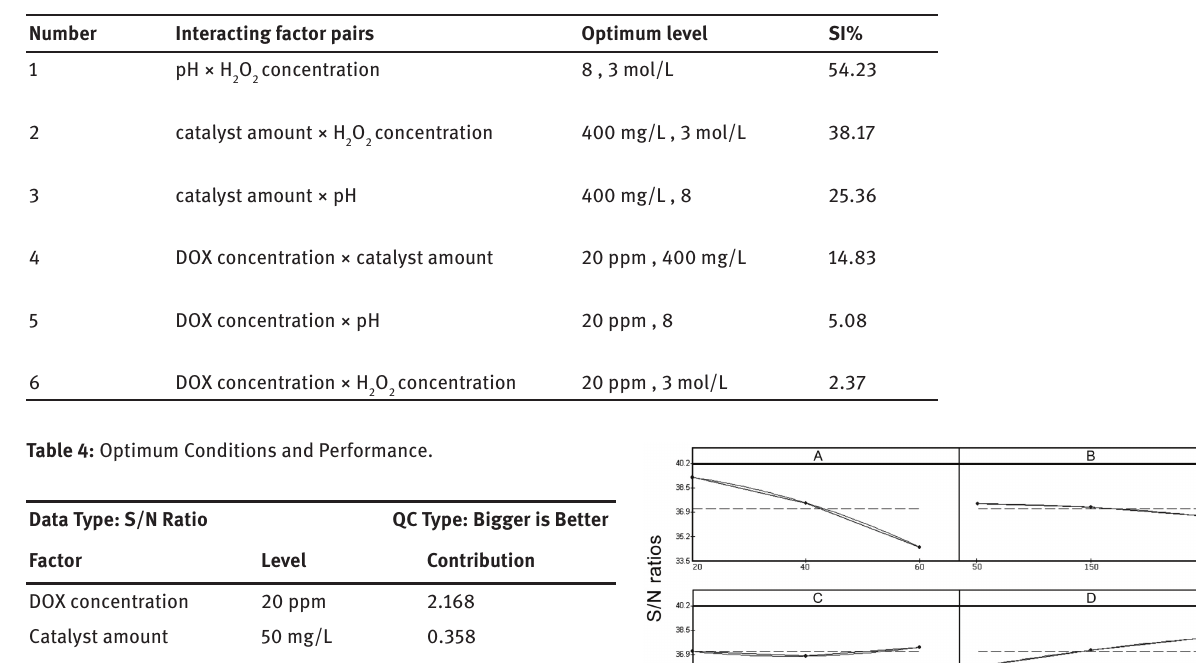
Table 3: Factors Interaction.